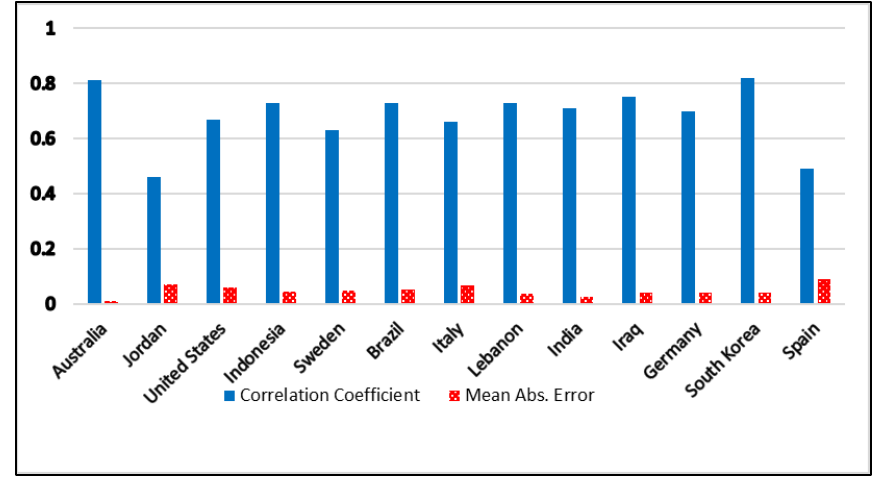
Figure 3. Correlation coefficients for 13 countries during the period between 15 February 2020 and 05 July